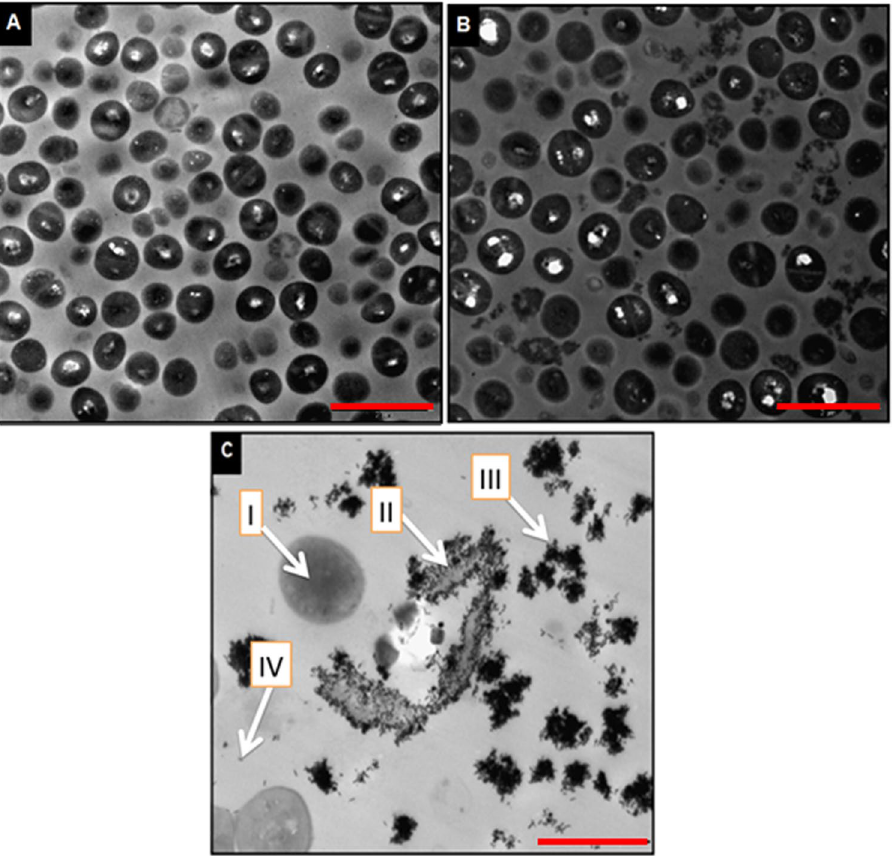
Figure 9. TEM images of ( A) untreated S . aureus , ( B ) S . aureus exposed to laser beam alone and ( C ) S . aureus pre-treated with PEG-GNR, then exposed to laser beam. (I) A live cell, (II) A dead cell, (III) clusters of